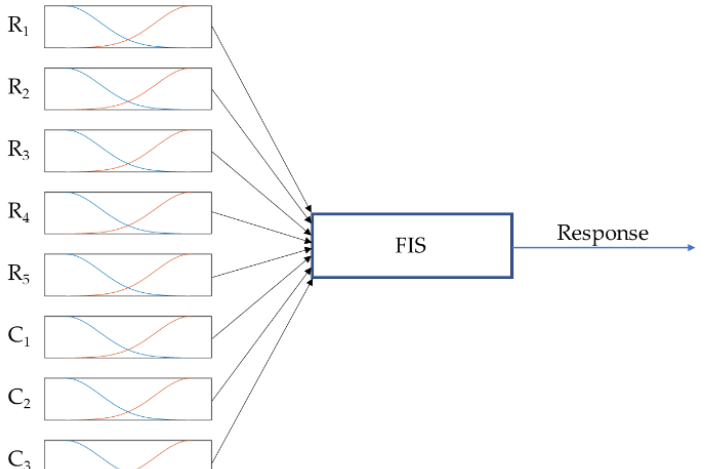
Figure 5. Zero-order Sugeno FIS.